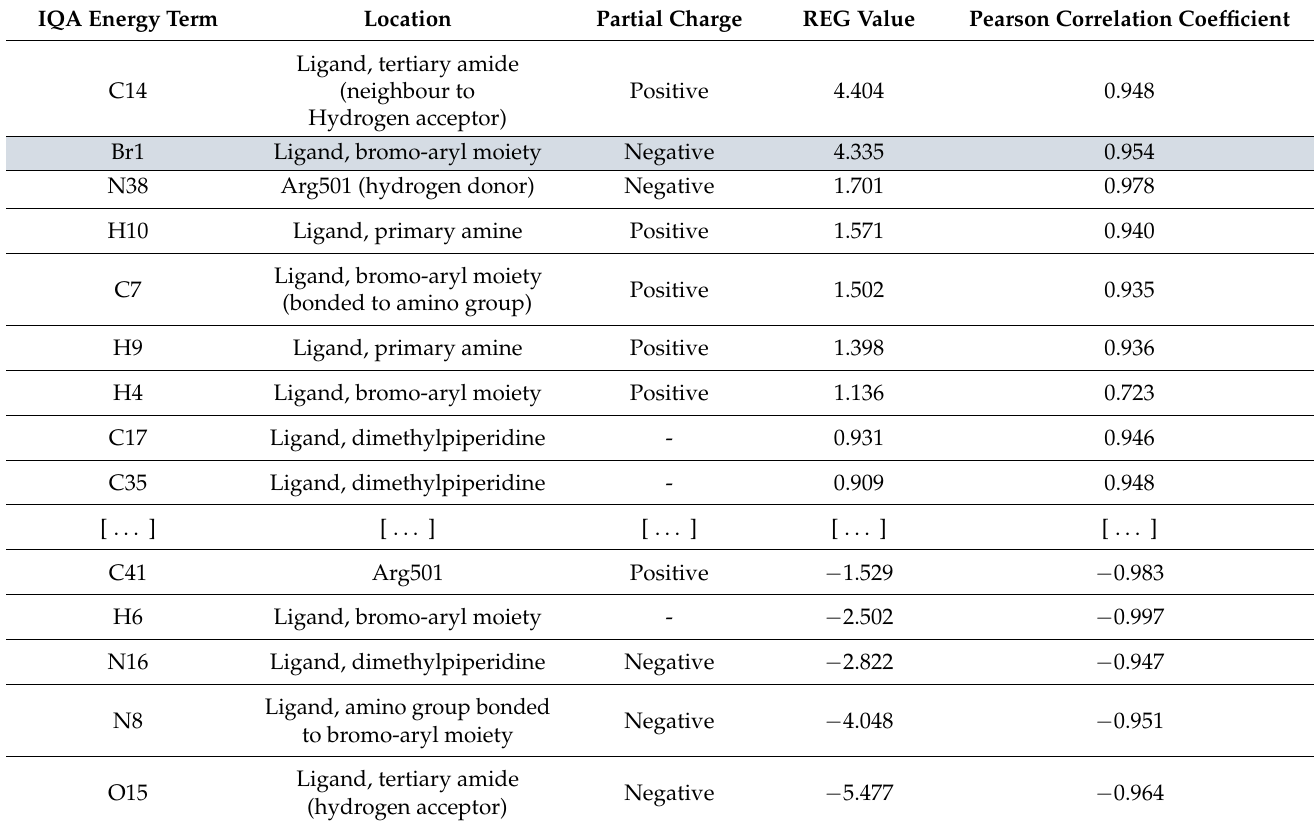
Table 7. Top and bottom REG values ( A-A (cid:48) ranking) for segment 3 in 3CJ2. The bromine contribution is